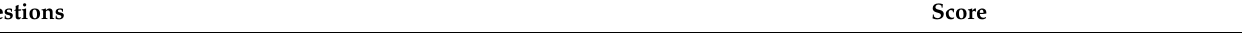
Table A1. EPICES score (Evaluation de la Pr é carit é et des In é galit é s de sant é dans les